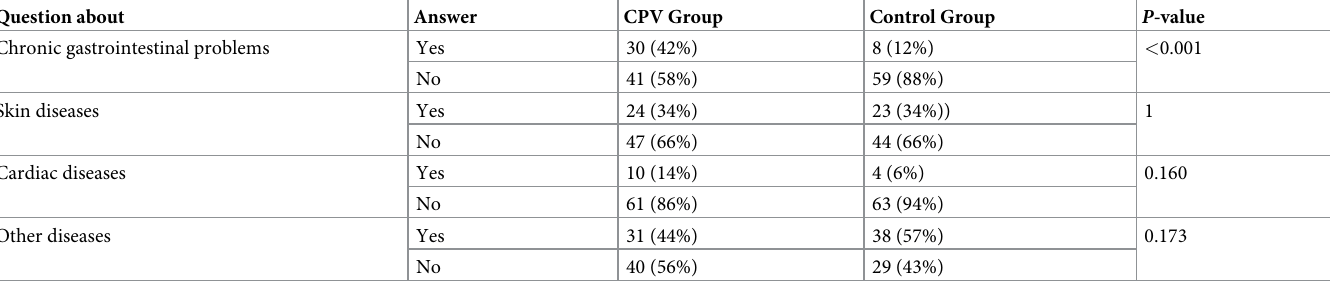
Table 3. Statistical evaluation of the main answers in the questionnaire (Fisher’s exact